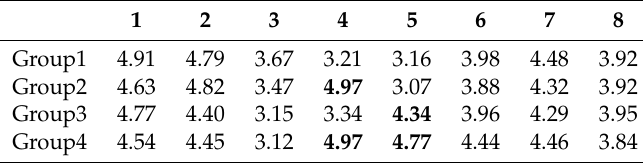
Table 7. Mean scores for participation motivations in esports among groups and scale